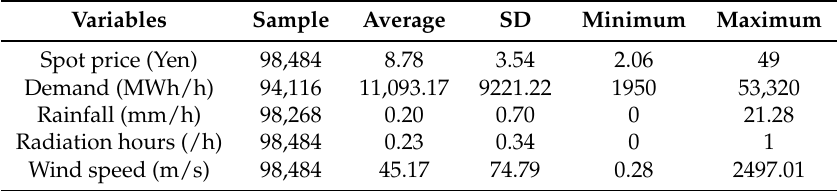
Table 2. Descriptive statistics.